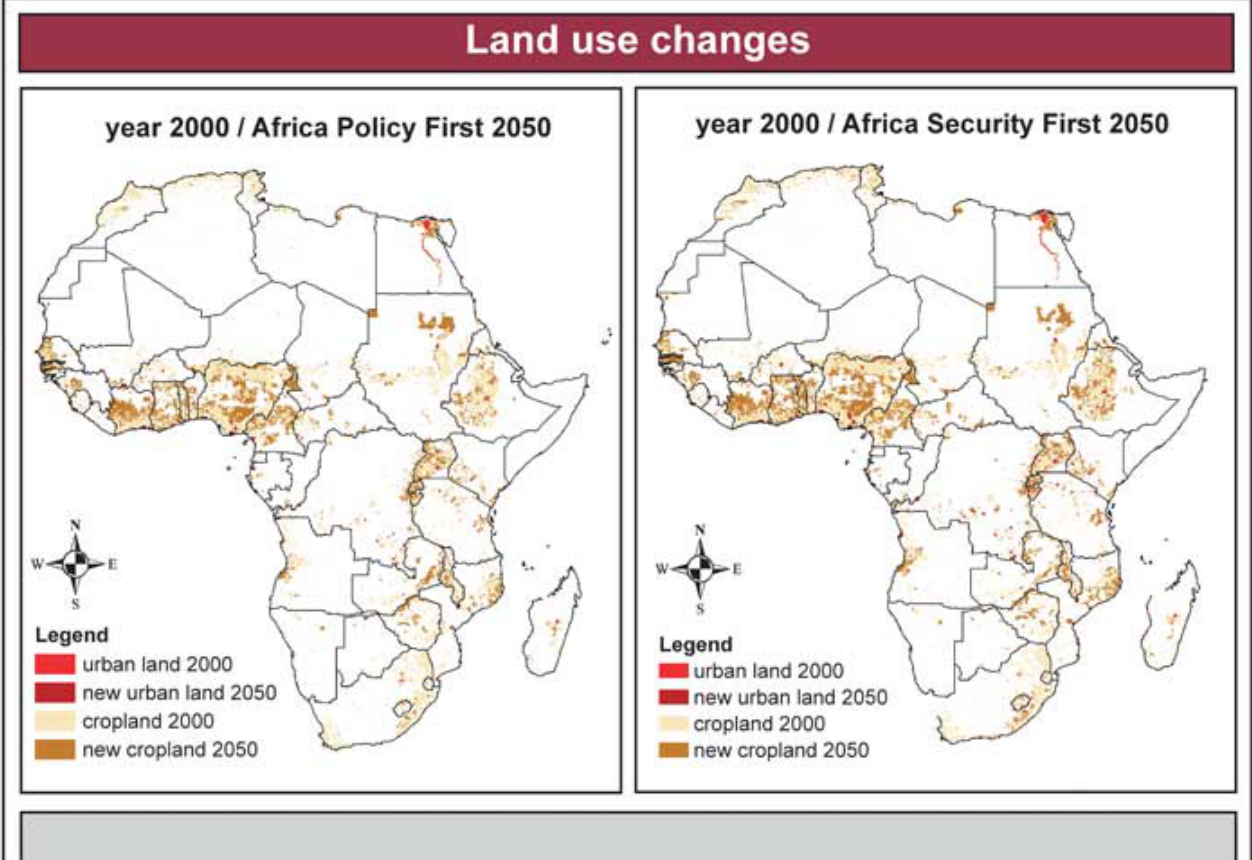
Figure 1. Expansion of settlement area and cropland between 2000–2050 for the (a) “Policy First” and (b) “Security First” scenarios, as calculated by